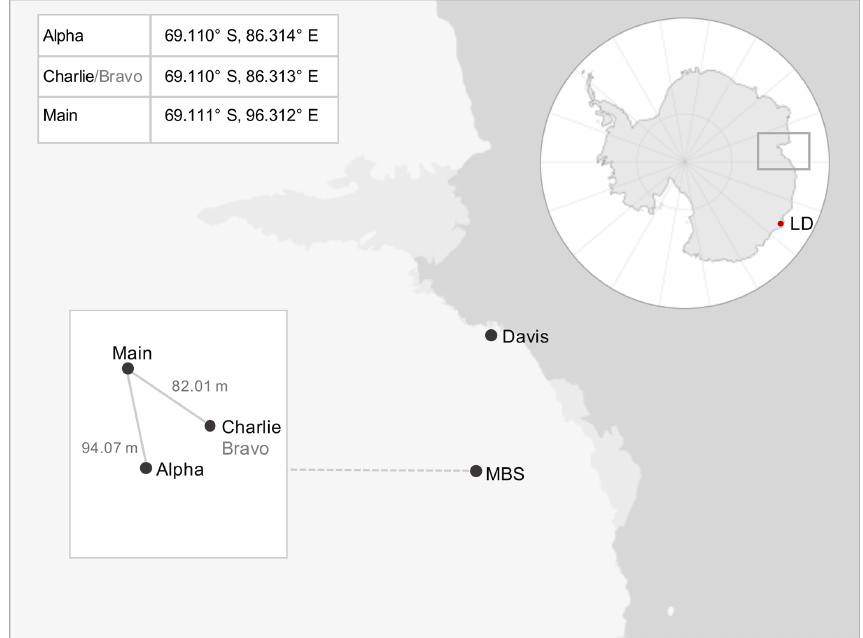
Figure 1. Site map of Mount Brown South (MBS) and Law Dome (LD, Dome Summit South site) in East Antarctica. The embedded table shows coordinates for the MBS Alpha, Bravo, Charlie, and Main ice core drilling